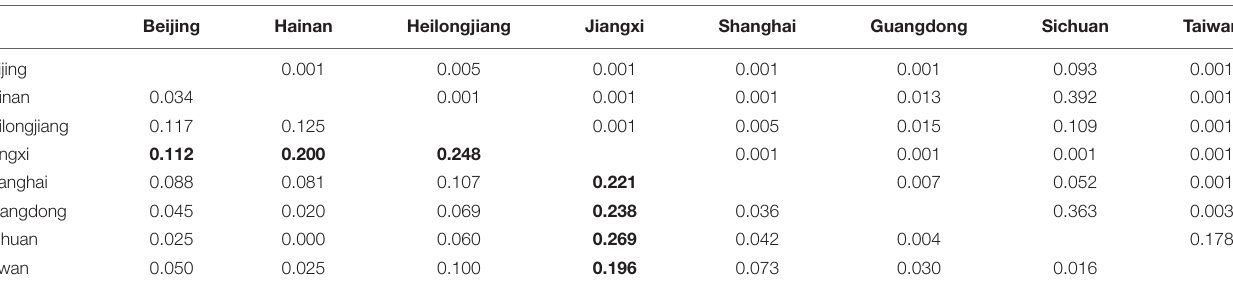
TABLE 6 | Genetic differentiation between pairs of geographic samples of C. tropicalis from different regions in China.